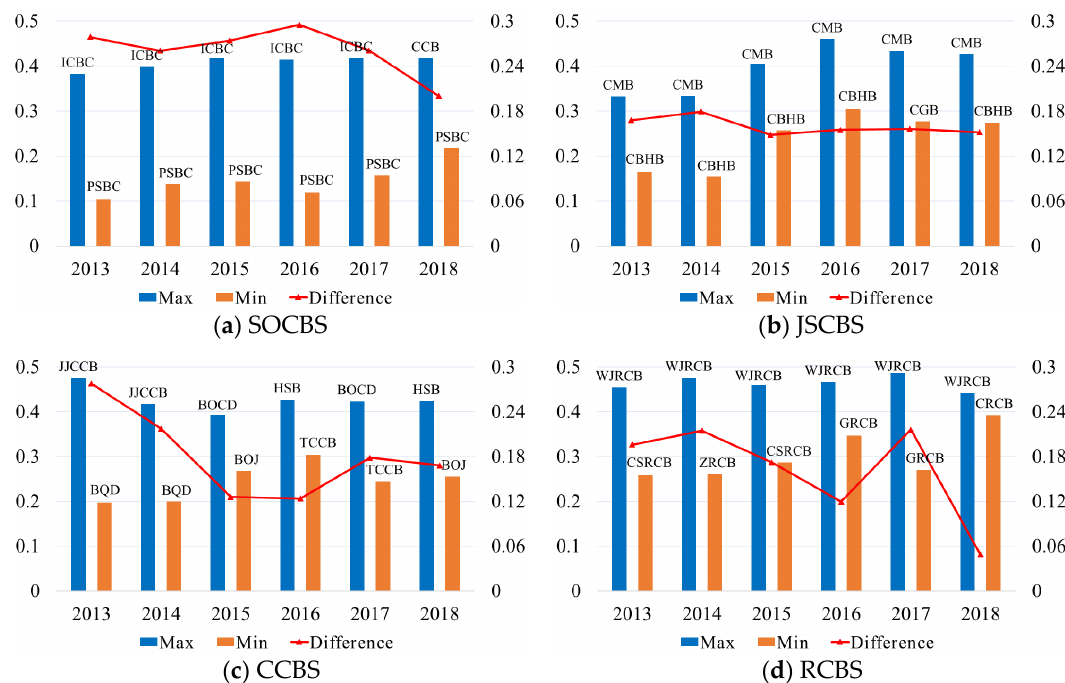
Figure 5. The values of maximum, minimum, and difference of Lerner Index for the four studied bank groups. (The left-hand ordinate indicates the LI values and the right-hand ordinate indicates the differences between maximum and minimum LI within each group; CCB: China Construction Bank,